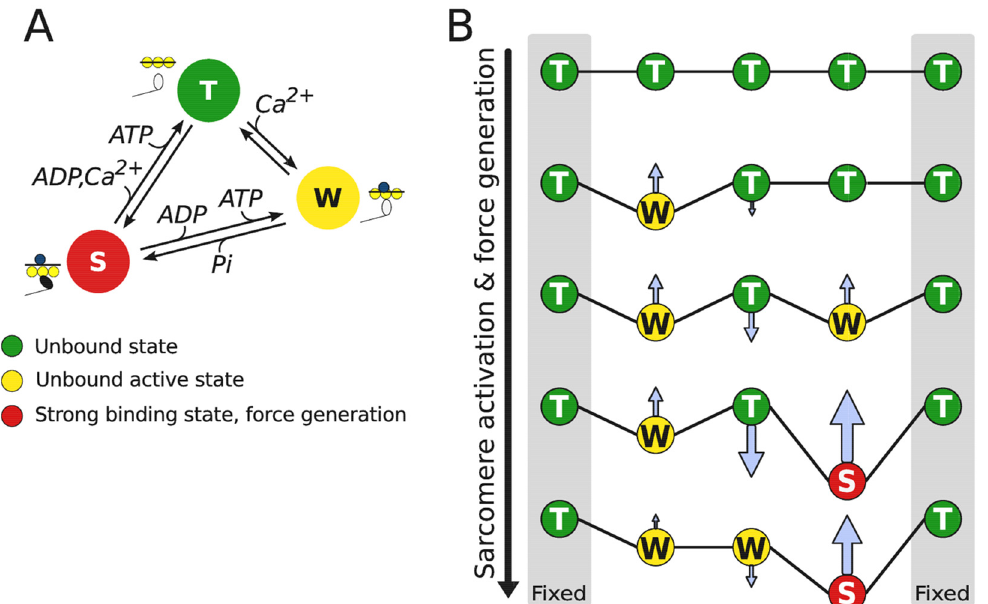
Fig 1. Computational model of the cross-bridge interaction. (A) Kinetic scheme of actin and myosin interaction used in three-state Huxley-type cross- bridge model. (B) Incorporating cooperativity into half-sarcomere activation and force generation. We consider an ensemble of five consecutive cross- bridges (binding states), out of which the first and the last ones are always in unbound state as boundary conditions. Arrows indicate the influences the neighboring binding states due to elastic deformation on tropomyosin, that connects all cross-bridges in a group, on binding of Ca 2+ (transition from T to W) or force generation (transition from W to